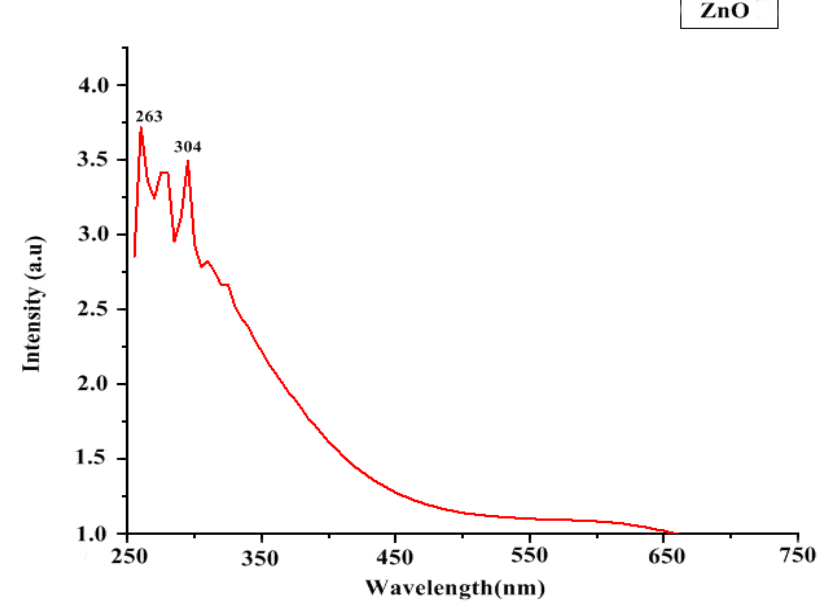
Figure 3. UV Spectroscopy of ZnO NPs.